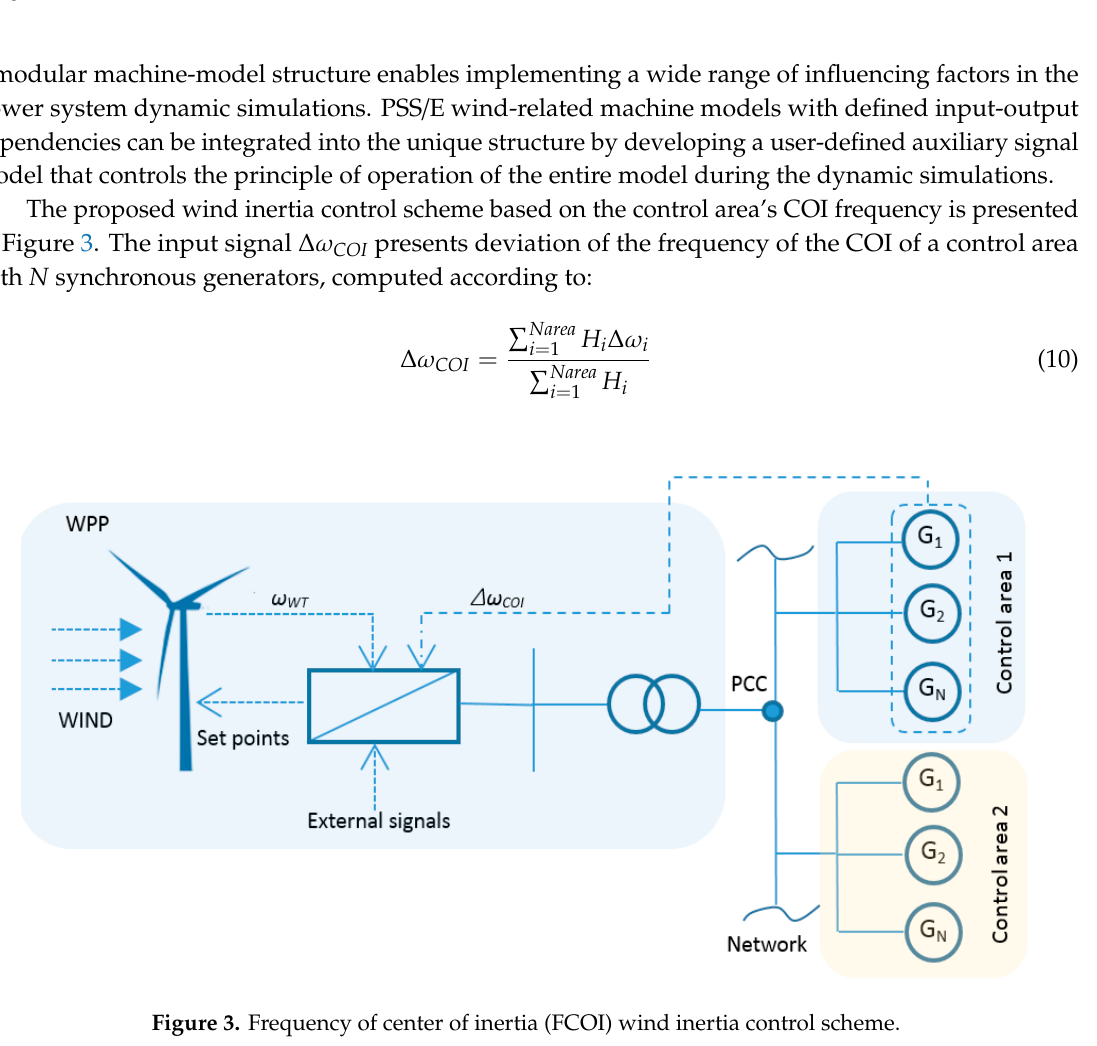
Figure 4. FCPCAU1 wind inertia controller structure.